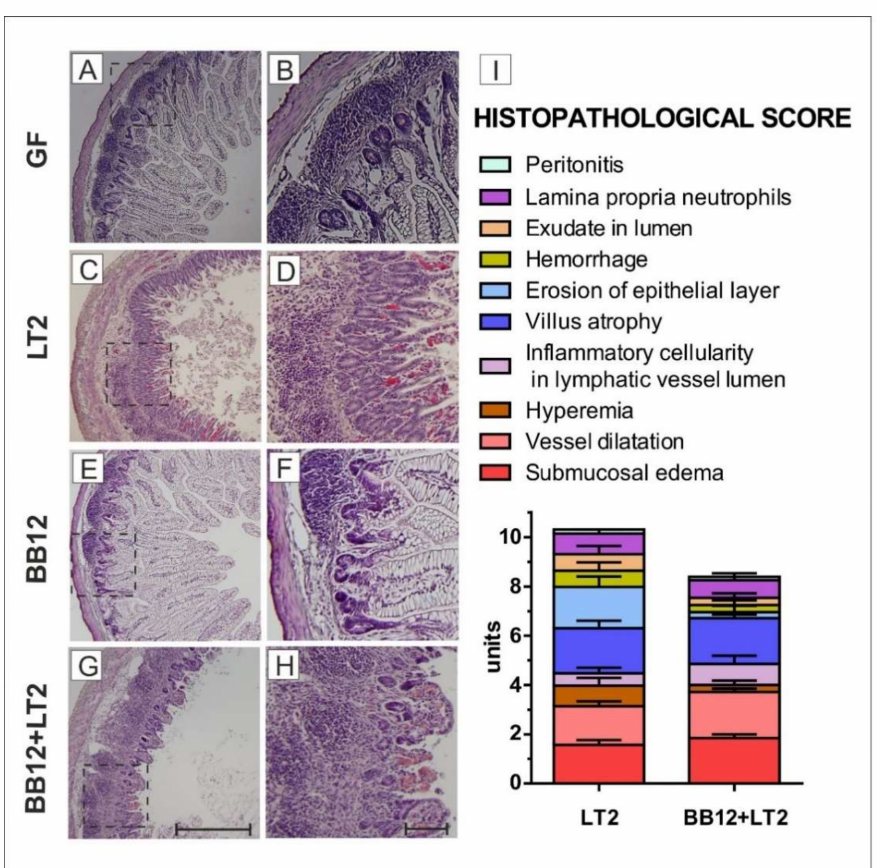
Figure 4. Histopathological evaluation of the ileum in the gnotobiotic piglets: germ-free (GF; A , B ), infected with S . Typhimurium LT2 for 24 h (LT2; C , D ), associated with B. animalis subsp. lactis BB-12 (BB12; E , F ), and associated with BB12 and infected with LT2 for 24 h (BB12 + LT2; G , H ). Bars represent 500 µ m ( G ) and 100 µ m ( H ), respectively. Histopathological changes affected the LT2 and BB12 + LT2 groups. Histopathological scores from the ileum of six piglets per group are depicted ( I ). 3.5. Changes in Claudin-1 and Occludin mRNA Expression in the Ileum and